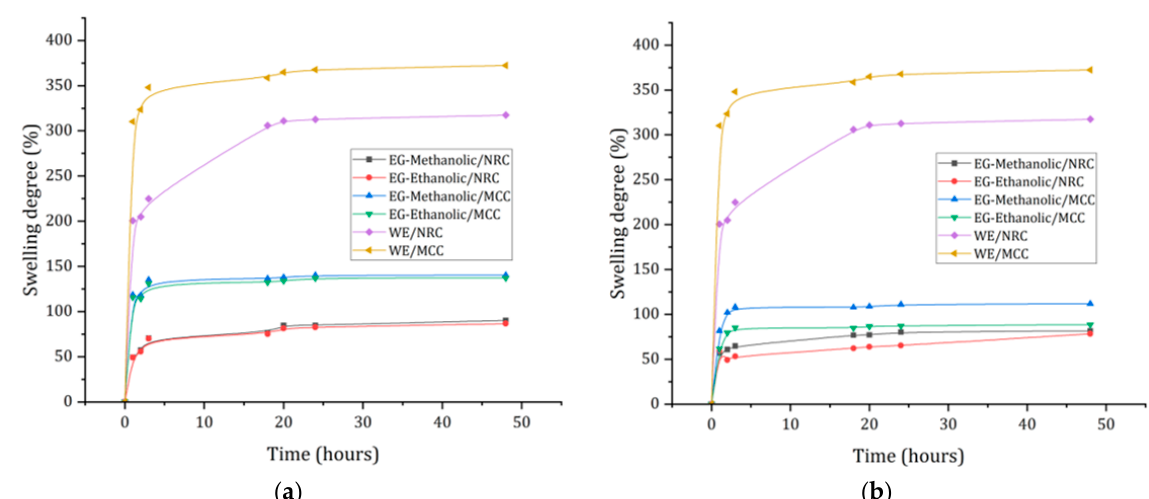
Figure 11. Degree of swelling of NRC and MCC hydrogel types in PBS solution with ( a ) hydrogel at relative 0.1% ( w / v ) and ( b ) hydrogel at relative 0.25% ( w / v ).